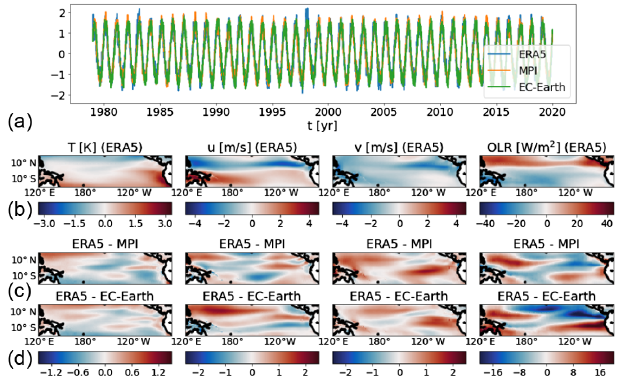
FIG. 13. (a) First (standardized) Isomap component for obser- vations (ERA5) and the two CMIP6 models (MPI and EC-Earth). Each component is standardized to unit variance. Correlations with the first principal component is higher than 0.98 indepen- dent of the dataset. (b), top row: linear regression of the first Isomap component onto ERA5. (c,d), bottom rows: differences between spatial projections of ERA5 and the two models. Note that the projections are spatial signatures of a single eigenvector and not four.